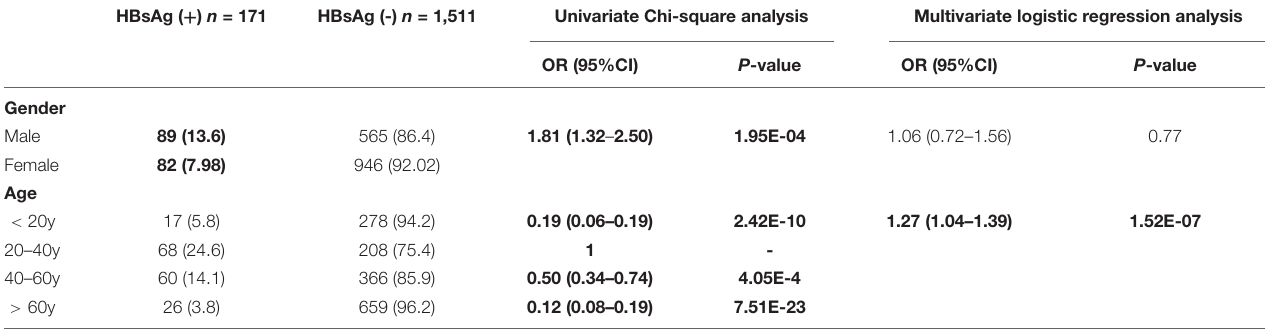
TABLE 2 | Socio-demographics of subjects according to HBsAg positivity. HBsAg ( + ) n =